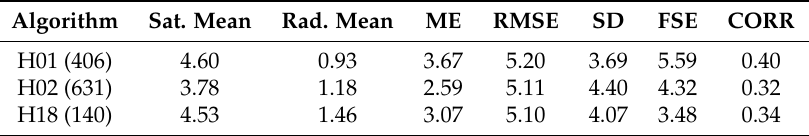
Table 4. Statistical continuous scores for Manaus for H01, H02 and H18. The number inside parenthesis represents the number of matched pixel pairs for each algorithm.